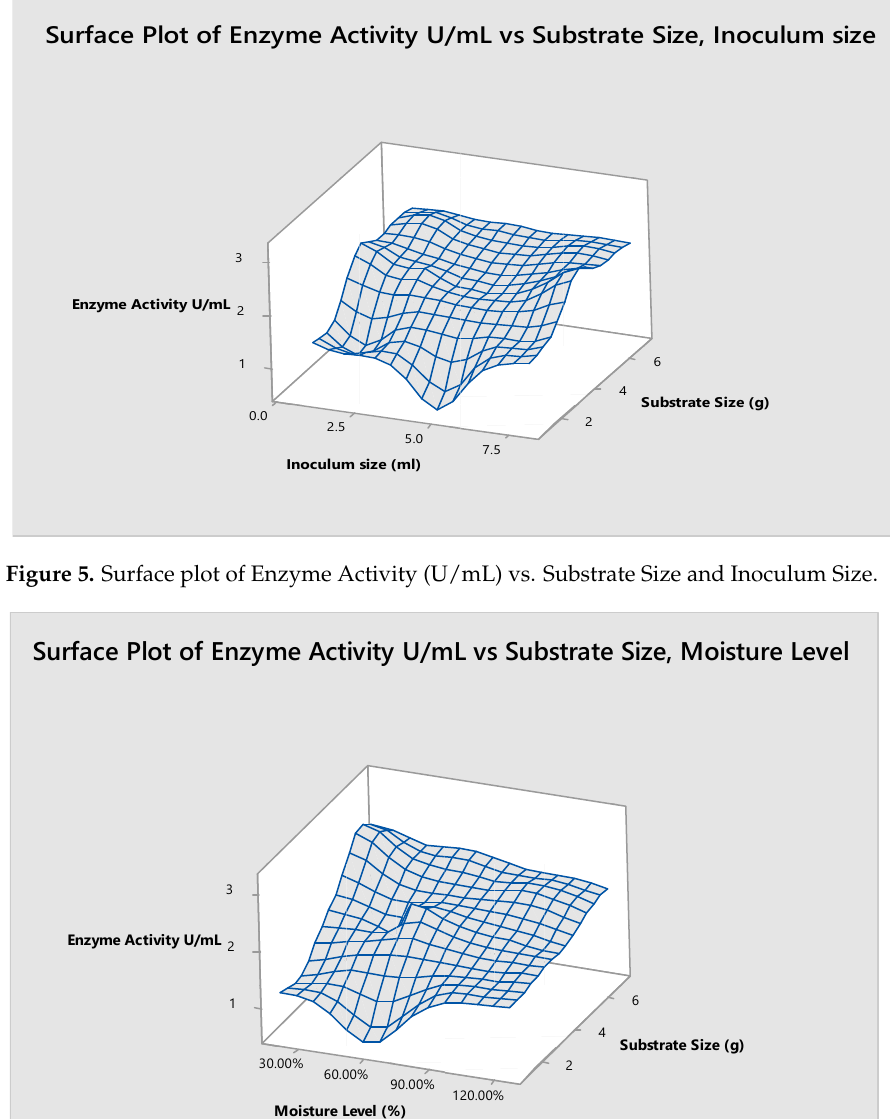
Figure 7. Surface plot of Enzyme Activity (U/mL) vs. Substrate Size and Incubation Days. 3.10. pH and Temperature The 3D surface plot in Figure 8 shows the effect of pH and temperature on enzyme activity. The peaks in this plot show that the maximum laccase activity was obtained at 40 °C. The three peaks were obtained with reference to the temperature and pH. The first peak was shown at 30 °C, with pH 5.5. The second highest peak was conducted at 40 °C,